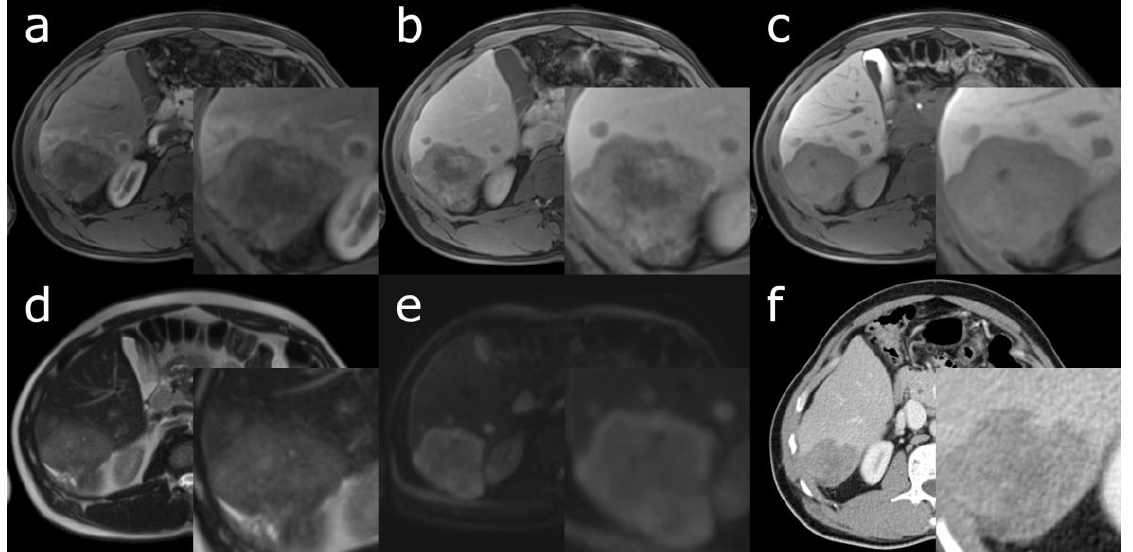
Figure 2. 48-year-old male with chronic hepatitis B infection in the absence of cirrhosis. Axial Gd- EOB-enhanced MRI of a cHCC-CCA in segment VI with predominant CCA histopathology, smaller satellite lesions and microvascular invasion. ( a ) Targetoid enhancement of the primary lesion in arterial phase, whereas the satellite lesions show rim hyperenhancement; ( b ) progressive targetoid enhancement in the portal venous and ( c ) hepatobiliary phase; ( d ) hyperintensity in a T2-weighted image; ( e ) targetoid appearance in diffusion weighted imaging (B-value 800); ( f ) CE-CT in venous phase 3 months prior to MRI showing targetoid hypointensity of the primary lesion.